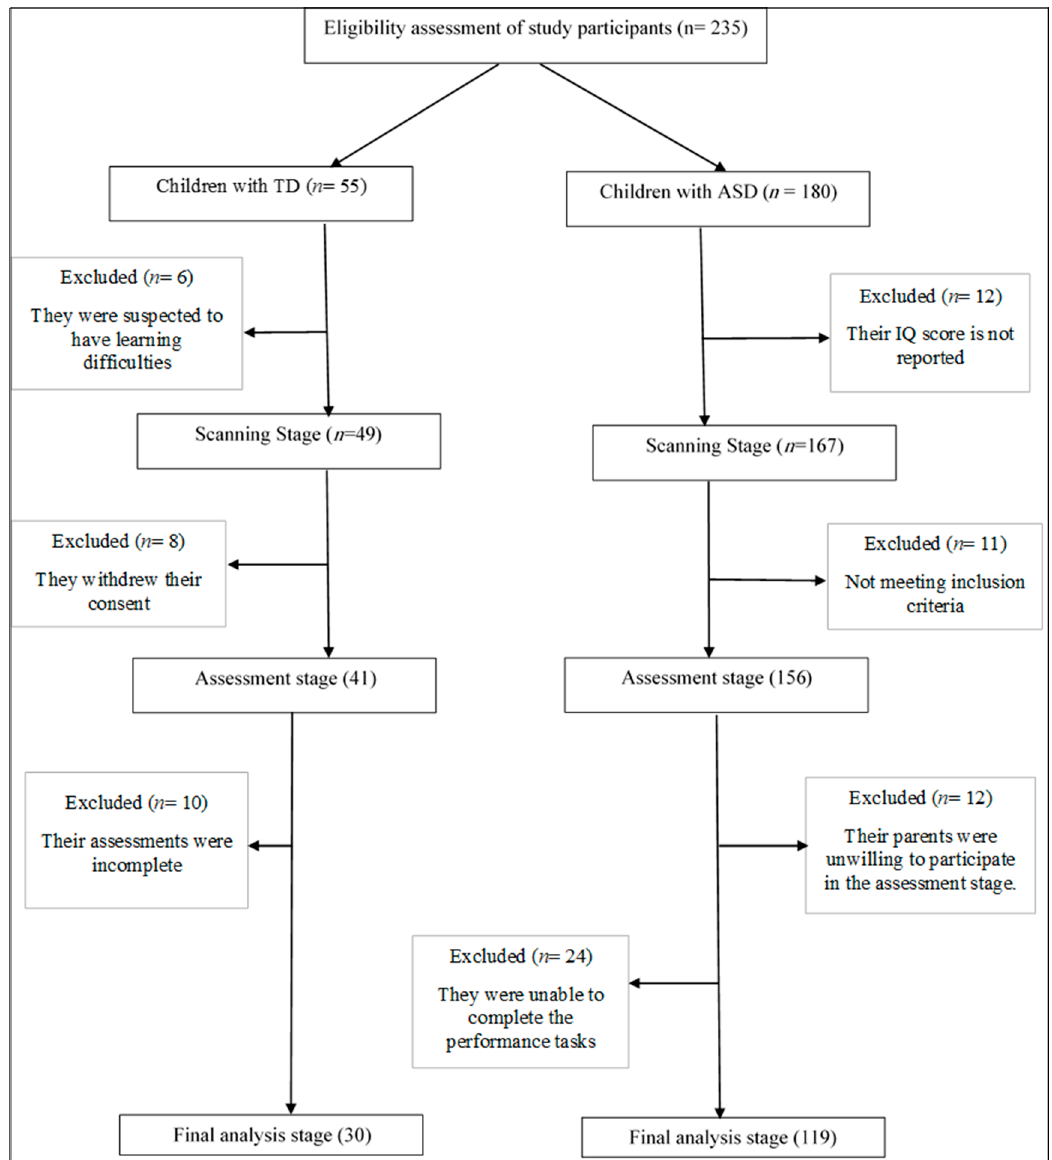
Figure 1. Recruitment of the Participants.